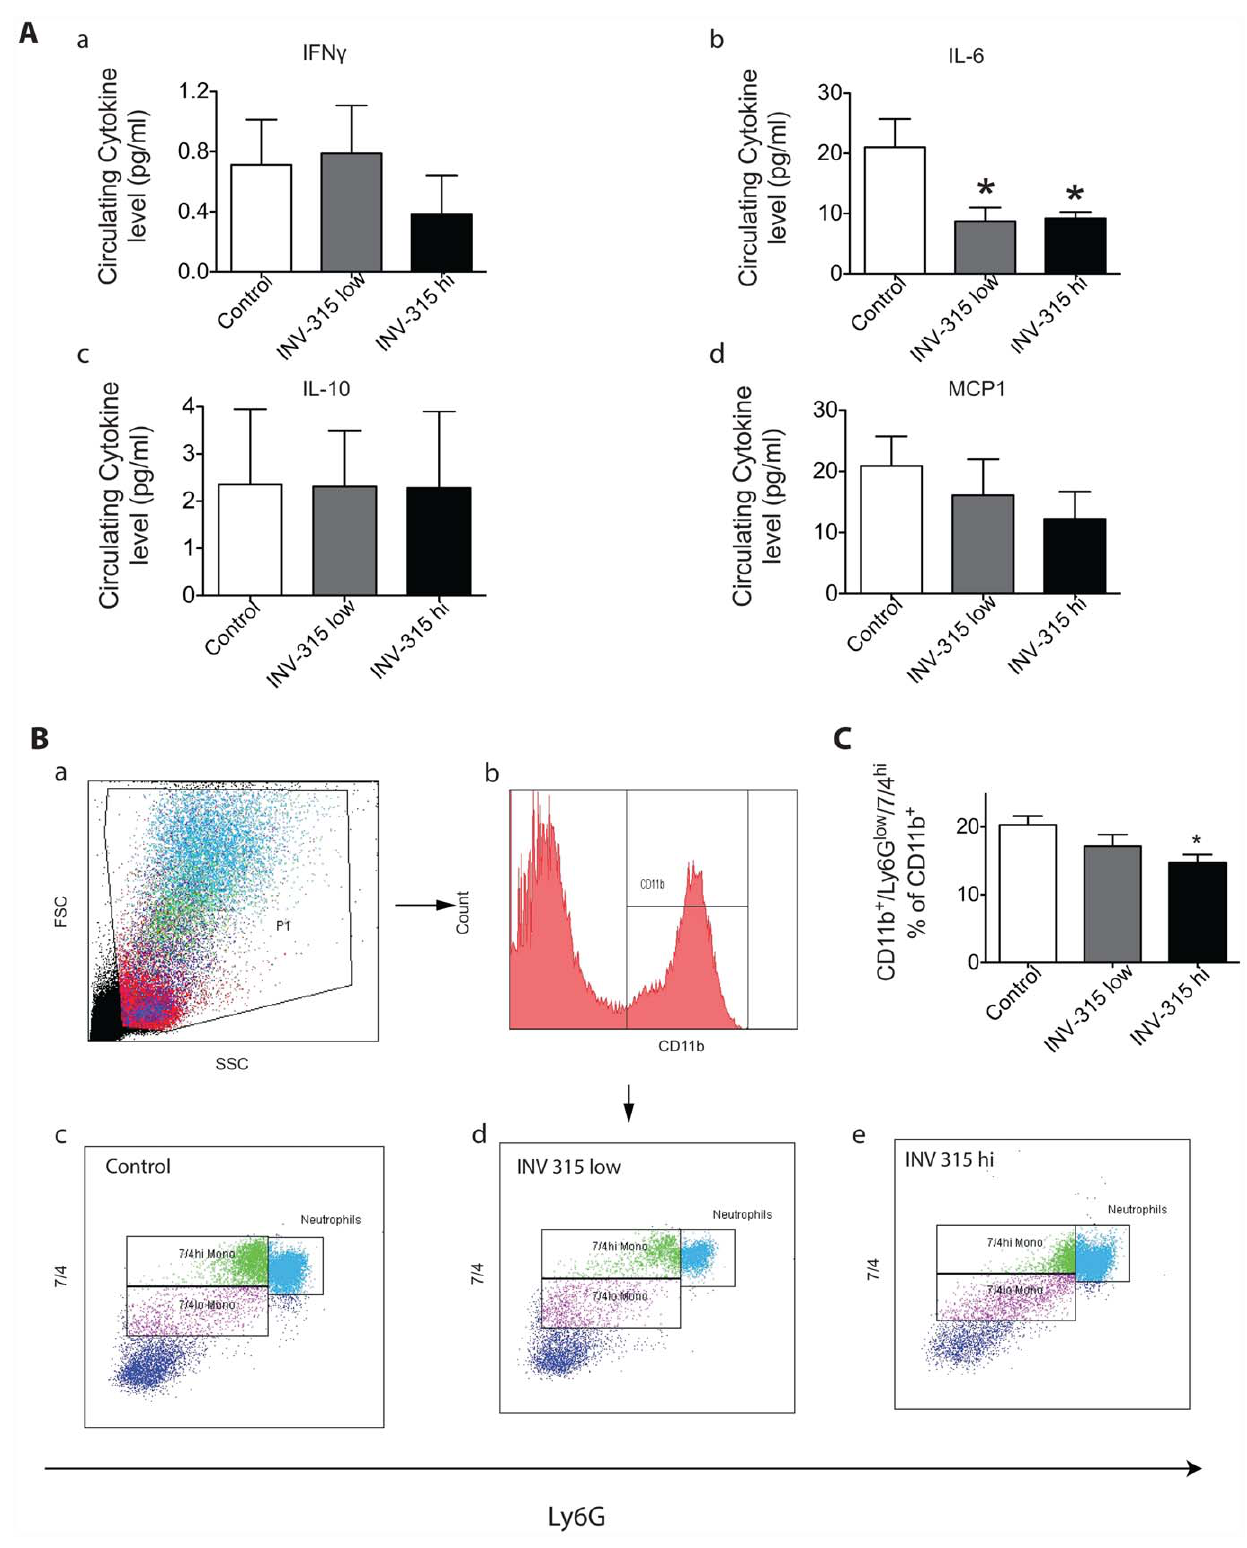
Figure 4. Effects of MPO inhibition on inflammatory cytokines and monocytes in blood from HFD-fed ApoE 2 / 2 mice. A. The concentrations of (IFN-g, IL-6, IL-10 and MCP-1) in response to INV-315 in ApoE 2 / 2 mice fed on HFD. B. Representative flow-cytometric dot plots showing circulating CD11b + Ly6G low 7/4 hi cells from mice blood. C. Flow cytometric analysis of inflammatory cells stained for CD11b + Ly6G low 7/4 hi . * P , 0.05 compared with control group. Data are mean 6 S.E.M. of 7–9 experiments from different mice.